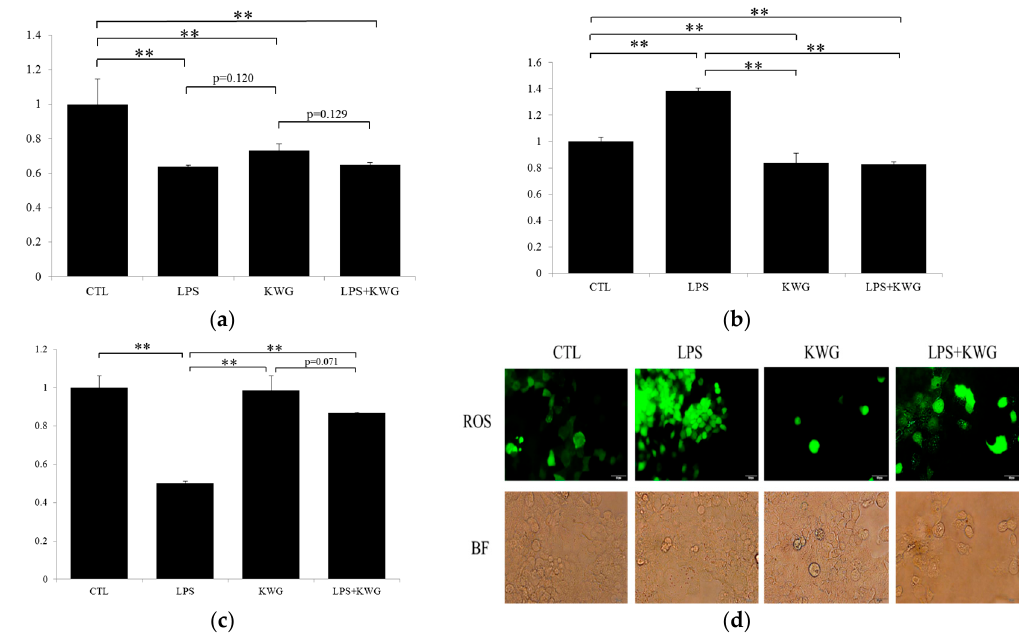
Figure 4. KWG strengthened anti-oxidative stress ability of Caco-2 cells against LPS-induced cell damage. Cells were treated with control (CTL), LPS, KWG or LPS + KWG for 24 h and the culture supernatant was collected. ( a ) Superoxidase dismutase (SOD) and ( b ) malondialdehyde (MDA) were detected by the kits according to the methods suggested by the manufacturer. ( c ) The ratio of SOD/MDA was analyzed to evaluate the overall anti-oxidative stress ability of the cells after different treatment. ( d ) Reactive oxygen species (ROS) were detected by the kit under fluorescence microscope, the corresponding cell morphology was captured under bright field (BF) (magnification: 200). The experiments were repeated for three times and representative figures or pictures were shown. ** p < 0.01.